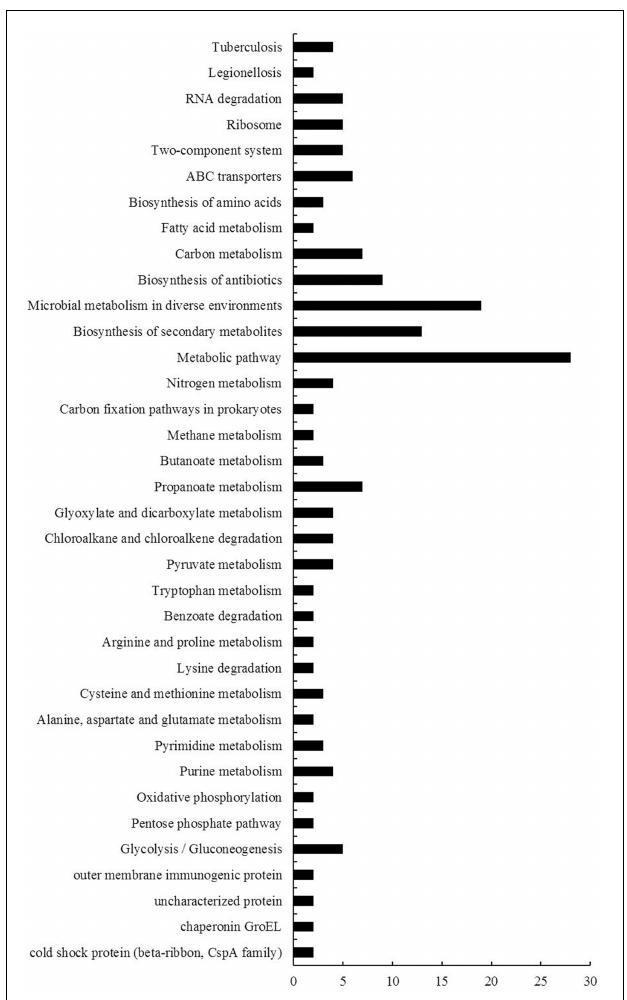
FIGURE 5 | KEGG pathway enrichment analyses of DEGs of B. diazoefficiens 113-2 between different nodules from different developmental periods of soybean. 36 KEGG pathways were analyzed and the x- and y-axes represent pathway categories and the number of genes in each pathway, respectively.